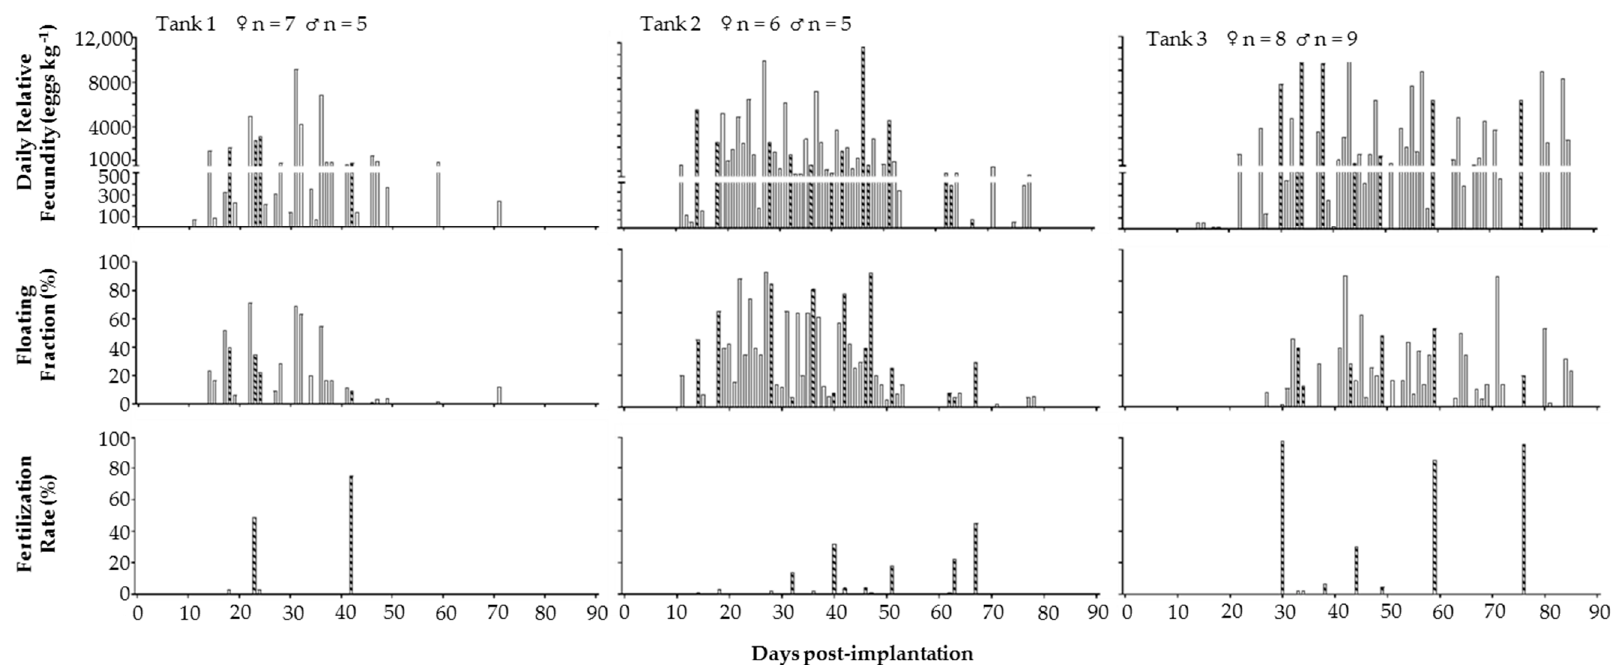
Figure 3. Trial 2A, GnRHa-treated tanks only: Spawning performance of first filial (F1) h ā puku ( Polyprion oxygeneios ) maintained on an annually cycling thermal regime that varied from cool temperatures in the winter months (10.0–12.5 °C) to warmer temperatures (17 °C) in the summer months prior to being held at 13.5 °C for the spawning season. Each tank contained GnRHa implanted females ( n = 21 distributed amongst three tanks; target dose of 100 μ g/kg − 1 ; achieved dose 79–139 μ g/kg − 1 ) and males ( n = 19 distributed amongst three tanks; target dose of 50 μ g/kg − 1 ; achieved dose 49–76 μ g/kg − 1 ). The number of fish in each tank is shown on the figures. Data are shown as estimates of daily relative fecundity (number of eggs produced per kg − 1 of mean body weight of the females in each tank), the percentage of floating eggs and the percentage of fertilized eggs from each spawning event. Striped and blank bars represent batches of eggs where fertilization was detected or absent, respectively. Blank-implanted fish were housed separately ( n = 3 tanks) from GnRHa-implanted fish. No eggs were detected from blank-treated fish. Due to the low number of viable eggs produced, eggs from only eight out of 25 fertilized spawns were submitted for parentage analysis and successfully genotyped. Results indicated that at least seven females (33% of all females) and five males (26% of all males) were contributing to the communal spawning events across the three GnRHa-treated tanks where fertilization was detected (Table 2; Tanks 1–3). A posteriori genotyping showed that prior to GnRHa administration (dose range: 88–131 μ g/kg − 1 ), mean oocyte diameters of ‘contributing’ females ranged between 0.9 and 1.2 mm. The achieved GnRHa dose of males contributing to successful spawning events ranged between 51 and 62 μ g/kg − 1 .